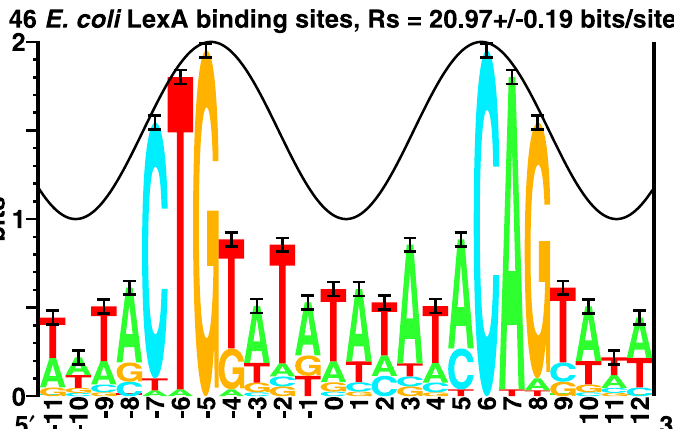
Fig 3. Sequence logo for LexA binding sites [33, 34]. 23 experimentally demonstrated DNA binding sites for the LexA protein and their complementary sequences from the bacterium E. coli (Genbank accession NC_000913.3) were collected and aligned using Delila instructions [35] that precisely define the site locations (see https://alum.mit.edu/ www/toms/lexa-inst.txt, and S1 Text lexa-inst.txt). The sequence logo shows stacks of letters corresponding to positions in the alignment. Within a stack, the height of a letter is proportional to the frequency of the base at that position. The entire stack height is the sequence conservation at that position, measured in bits [31]. I-beam error bars show the likely variation caused by the small sample size [31]. The sum of the heights of the logo stacks, the ‘area’ under the logo, is R sequence = 20.97 ± 0.19 bits per site which can be predicted from the size of the genome ( G ) and the number of sites ( γ ) using R frequency = − log 2 ( γ / G ) bits per site [31, 32]. The peak of the sine wave indicates where the protein faces the major groove of the DNA; intriguingly, this follows the sequence conservation shown by the logo [34,